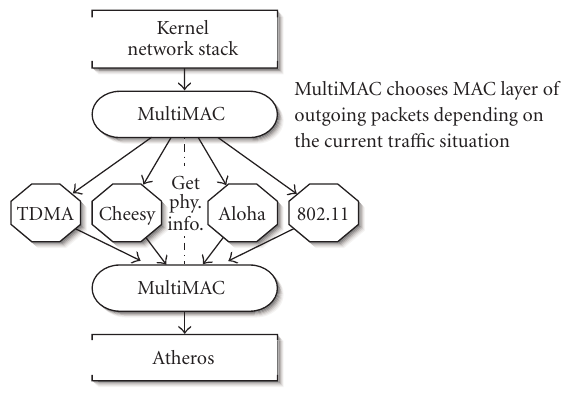
Figure 3: On the sending side, MultiMAC uses environmental stim- uli to determine the path of a